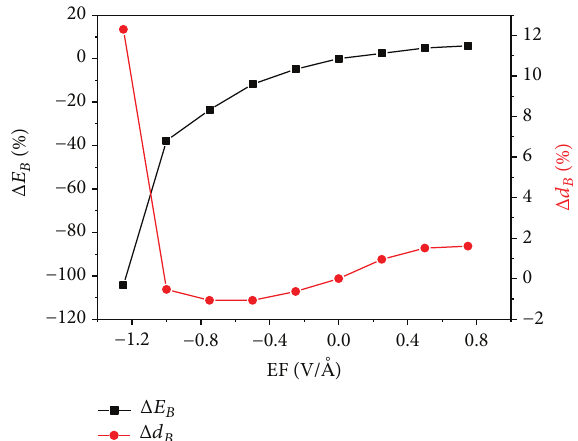
Figure 9: Effects of EF on the energy barrier and its location with respect to